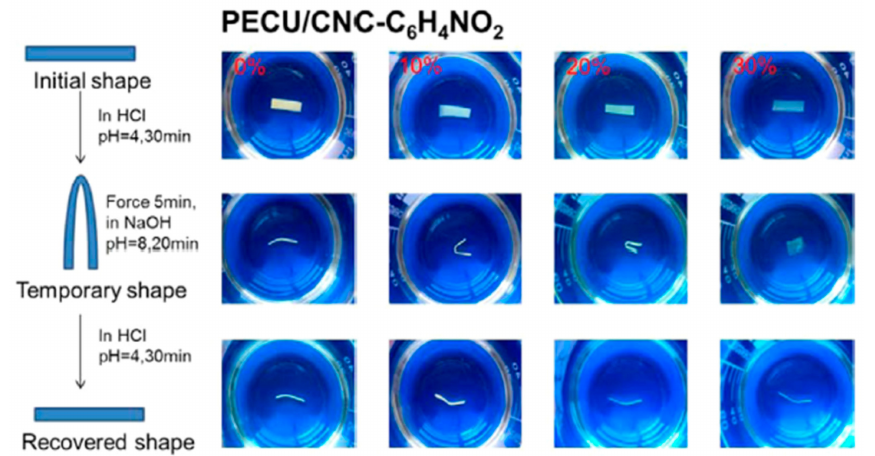
Figure 16. The changes of shape of PECU/CNC-C 6 H 4 NO 2 when immersed in HCl solution (pH 4.0) and NaOH solution (pH 8.0) at room temperature (Adapted and reprinted with permission from ref. [88] © 2015, American Chemical